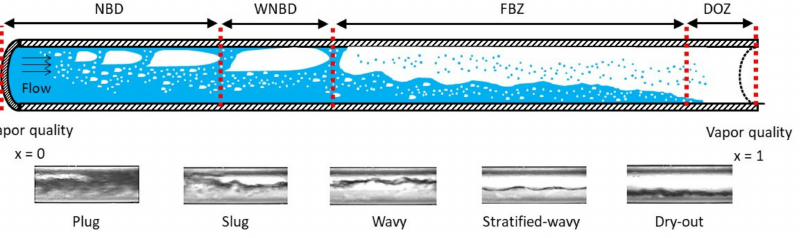
Figure 6. Illustration of the heat transfer zones during evaporation and the representative flow visualizations from the tube